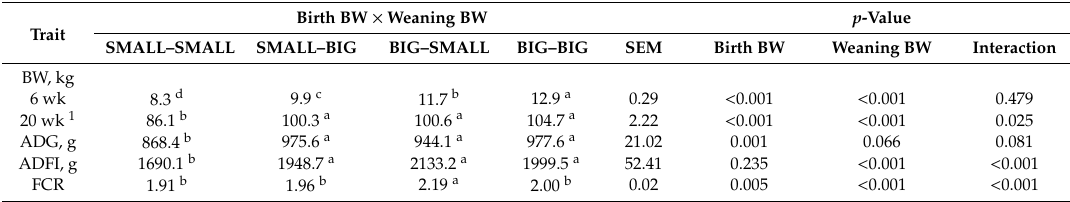
Table 2. Body weight (BW), average daily gain (ADG), average daily feed intake (ADFI) and feed conversion ratio (FCR) from 6 to 20 weeks of age (Least square means [LS mean] ± Standard error mean [SEM]) for four groups of pigs classified according to their birth BW as SMALL (BW ≤ 1.15 kg) or BIG (BW > 1.15 kg), and re-classified according to their weaning BW as SMALL (BW ≤ 5.5 kg) or BIG (BW > 5.5 kg). Birth BW × Weaning BW p -Value Trait SMALL–SMALL SMALL–BIG BIG–SMALL BIG–BIG SEM Birth BW Weaning BW BW, kg 6 wk